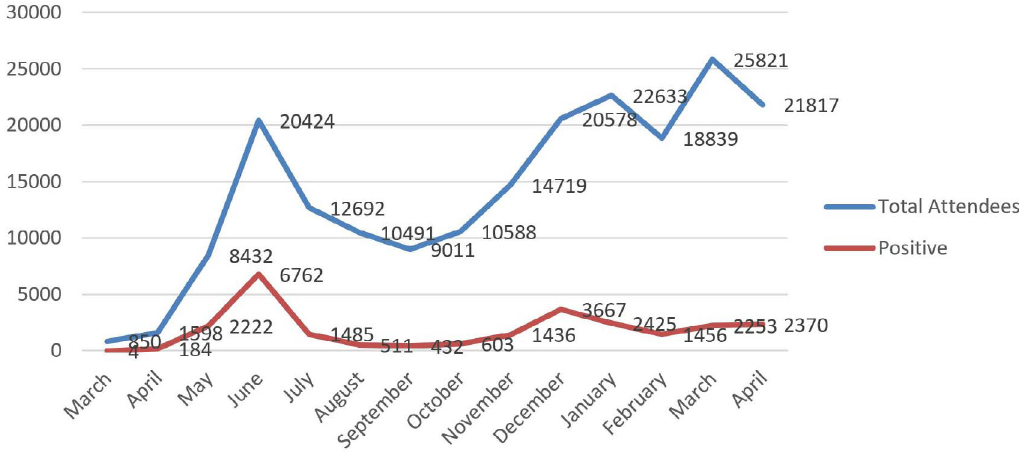
Fig. 1. The number of attendees and positive COVID-19 PCR cases in the Reference Laboratory of the